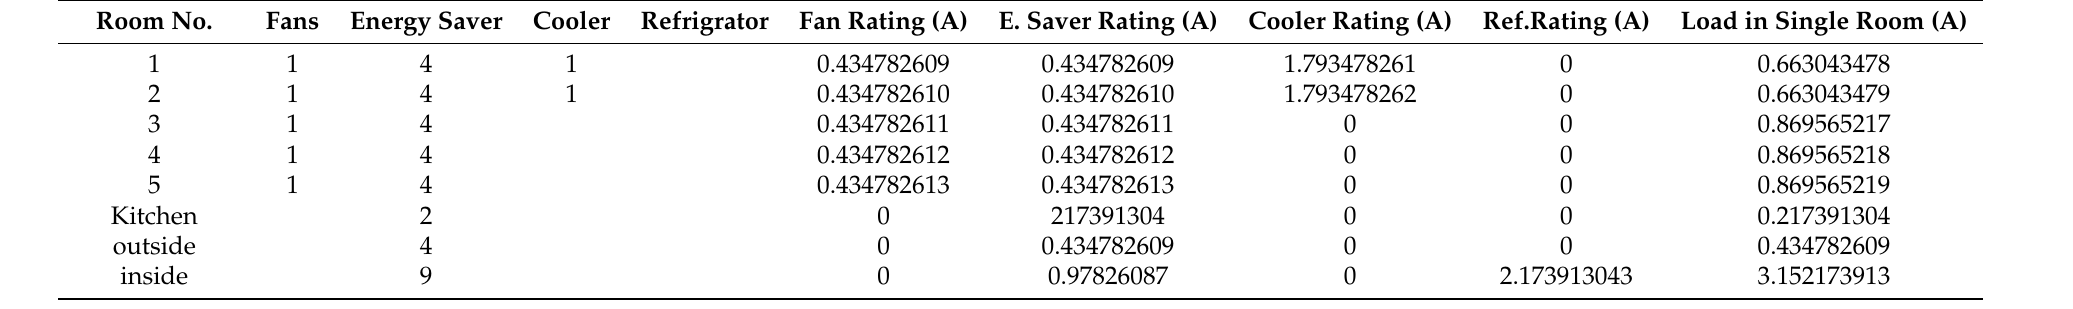
Table 8. Staff Hostel existing load